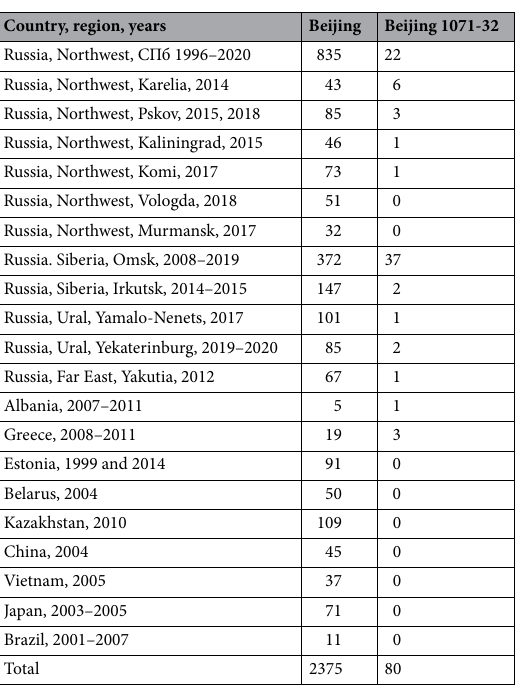
Table 3. Detection of the Beijing 1071-32-cluster by the developed PCR assay in local collections. Beijing genotype was detected using spoligotyping, or PCR targeting dnaA - dnaN ::IS 6110 (Mokrousov et al., 2014) or based on VNTR-clustering. Beijing 1071-32-cluster was detected by real-time PCR analysis of SNPs in Rv0144 , Rv0373c , and Rv0334 as described in this study. Geographic locations are shown on Fig. 3.